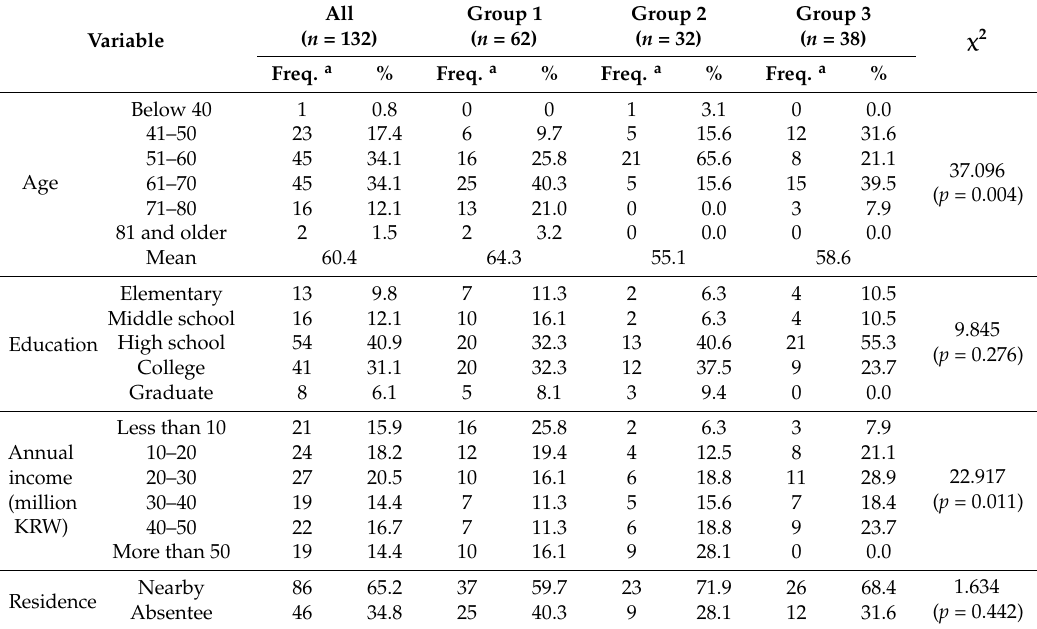
Table 3. Socio-economic characteristics of survey